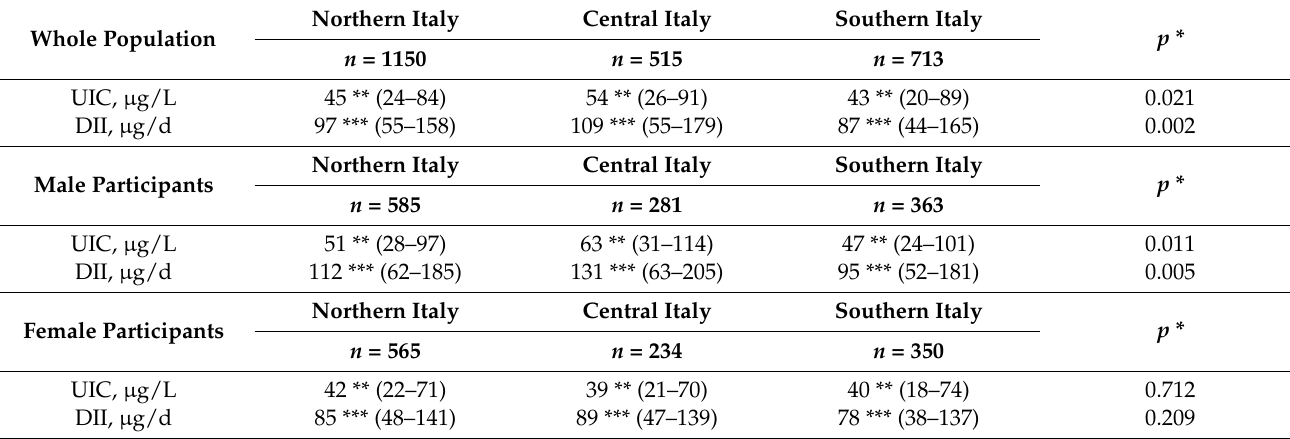
Table 4. Medians (IQR) of urine iodine concentration (UIC) and daily iodine intake (DII) by the Italian area and by gender. Whole